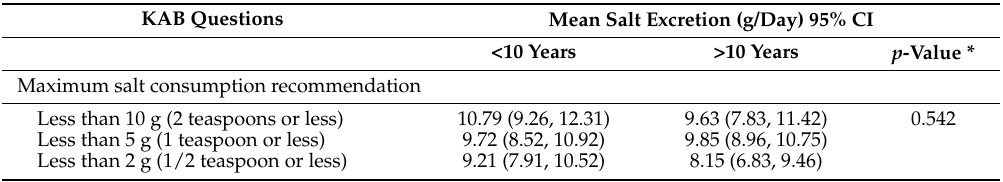
Table 4. Association between KAB and salt excretion (g/day) by level of